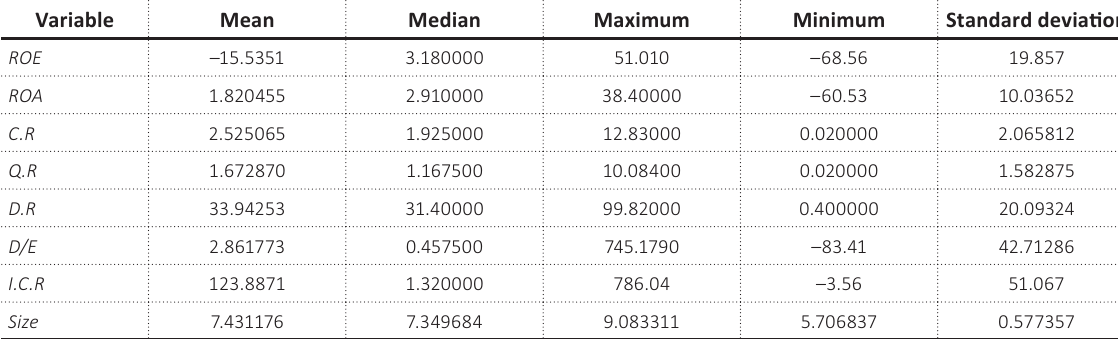
Table 1. Descriptive statistics of the study